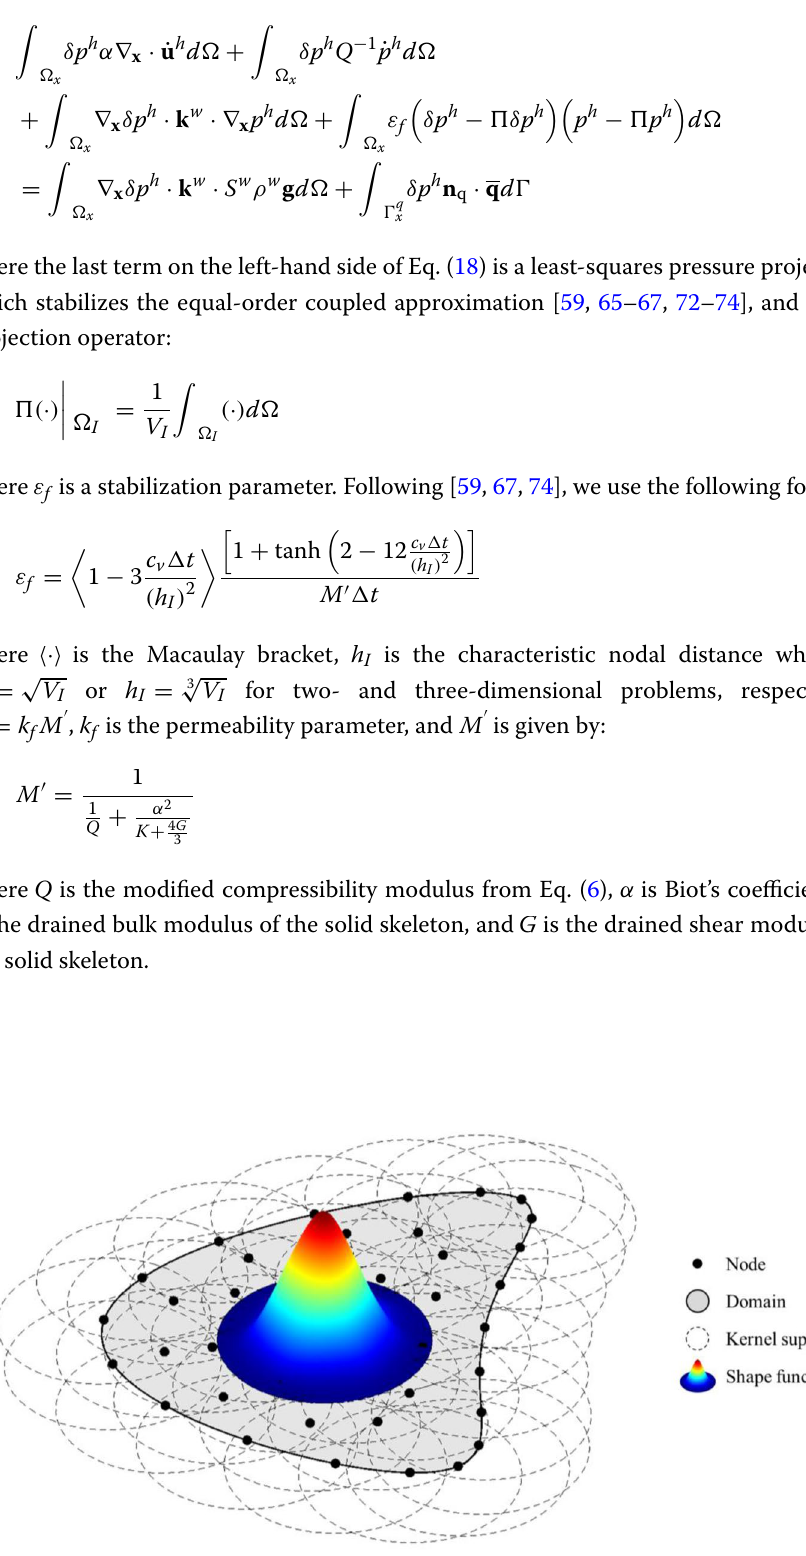
Fig. 1 A domain (cid:31) X is discretized by a set of nodes. Each node has a kernel support (circular in this example) where the shape function (cid:31) I is